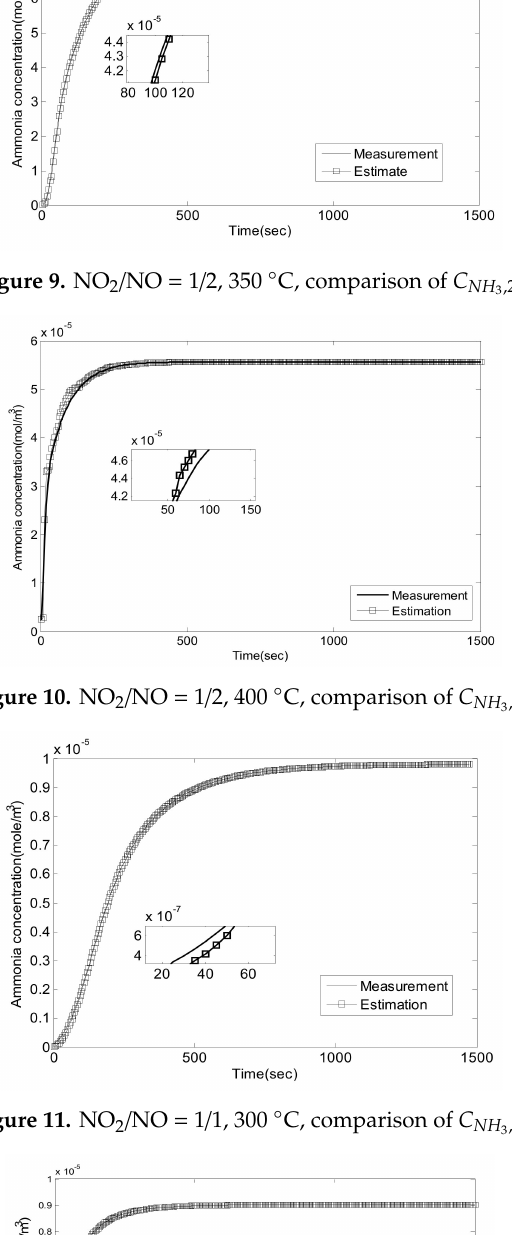
Figure 11. NO 2 / NO = 1 / 1, 300 ◦ C, comparison of C NH